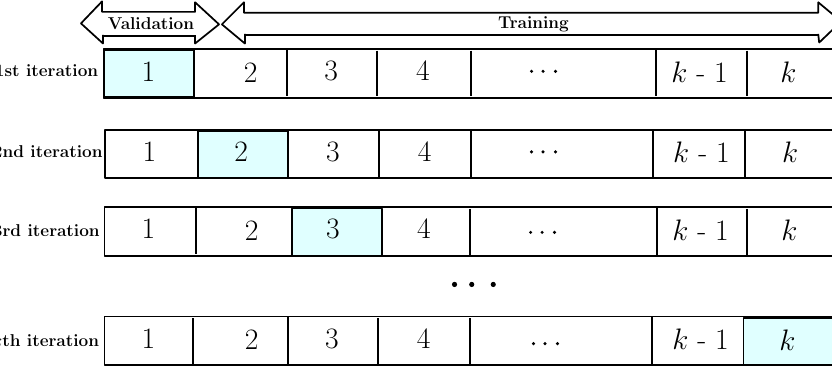
Figure 5. k -fold